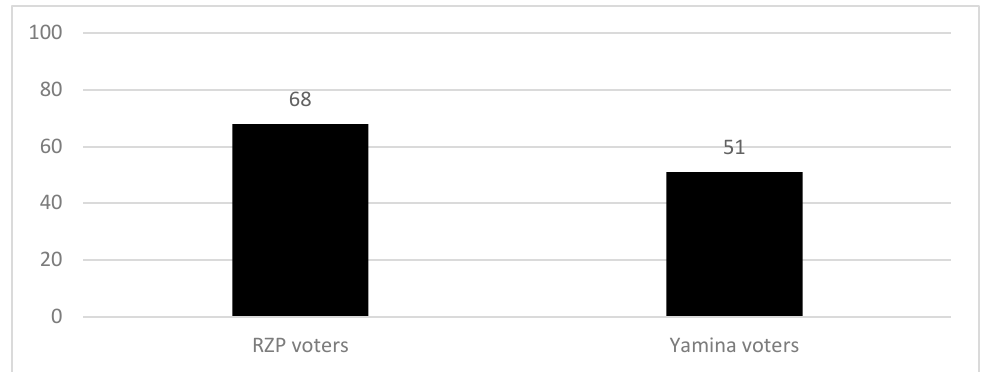
Figure 20. Agree that Israel needs a strong leader who will disregard the Knesset, media, or public opinion in order to deal with the special issues facing the country (by voting in 2021, %) Source: Israeli Democracy Index, 2021.